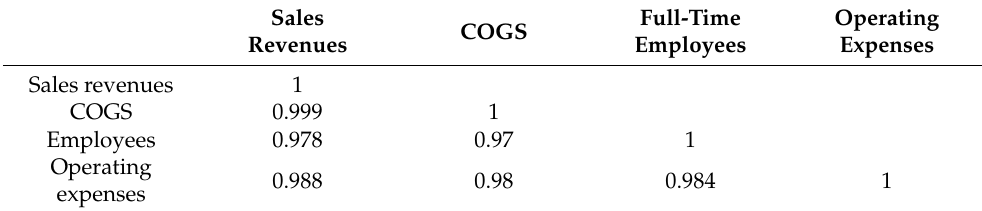
Table 8. Correlation coefficients between input and output